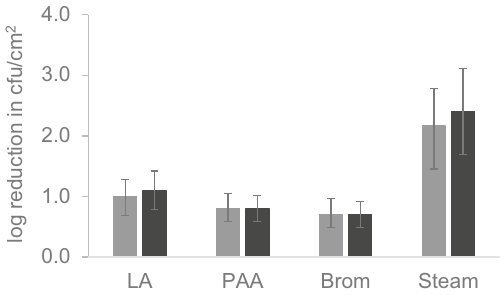
Figure 3. Beef flank inoculation assay. LA, 2% lactic acid (1 min). PAA, 200 ppm peroxyacetic acid (1 min). Brom, 300 ppm BoviBromine (1 min). Steam, flank surface temperature achieved 82 °C with dry steam (15 s). Statistical significance between clb + E. coli and reference E. coli O157:H7 was calculated by Fisher’s exact test ( p ≥ 0.05, not significant). Data presented represents average of 2 biological replicates, 12 technical replicates each on individual beef flanks. clb + E. coli , E. coli